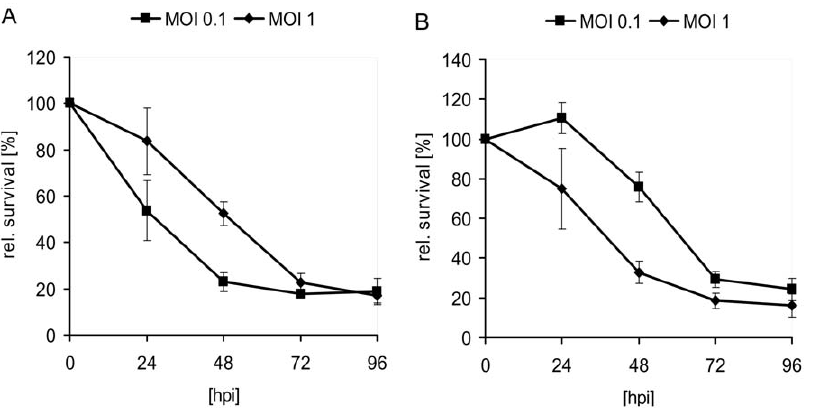
Figure 2. Viability of hepatocellular carcinoma HuH7 (A) and PLC (B) cells after GLV-1h68 infection at MOIs of 0.1 and 1.0, respectively. Viable cells after infection with GLV-1h68 were determined by use of 3-(4,5-dimethylthiazol-2-yl)-2,5-diphenyltetrazolium bromide (MTT) (Sigma, Taufkirchen, Germany). Mean values (n=3) and standard deviations are shown as percentages of respective controls.